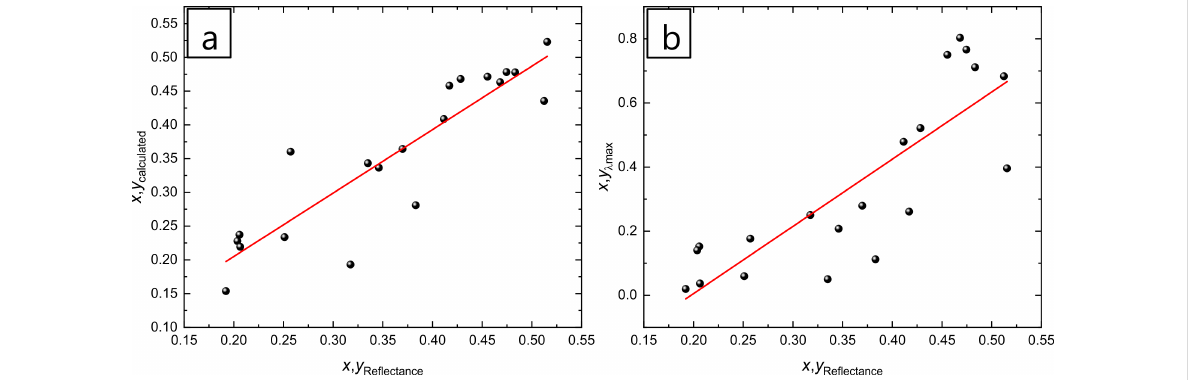
Figure 5: (a) x and y values calculated from the proposed model as a function of x and y values obtained from the reflectance measurements. (b) x and y values calculated from the wavelength of the maximum reflectance as a function of x and y values obtained from the reflectance measure-